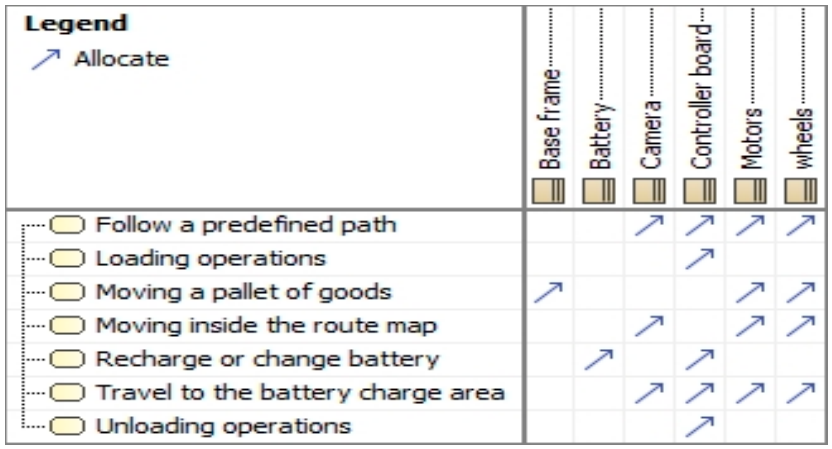
Figure 14. Component-Function allocations.